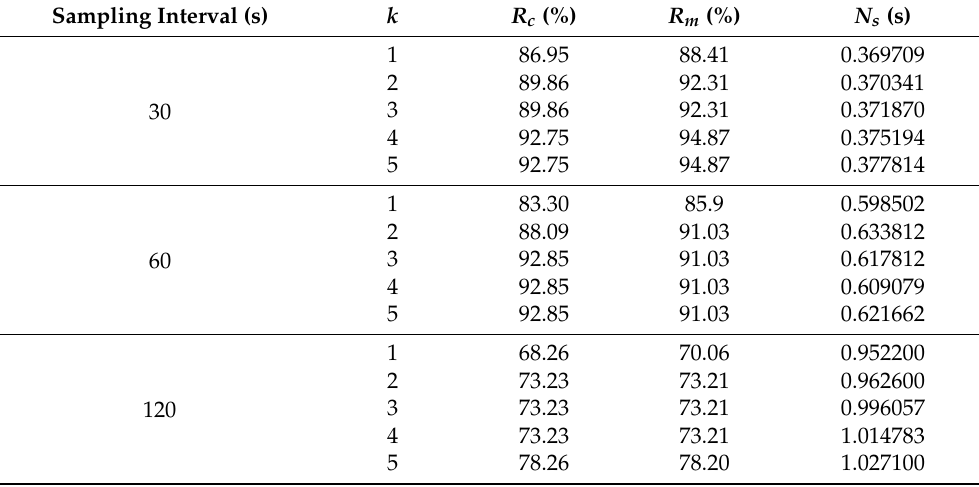
Table 3. Comparison results under different sampling frequencies and path candidate